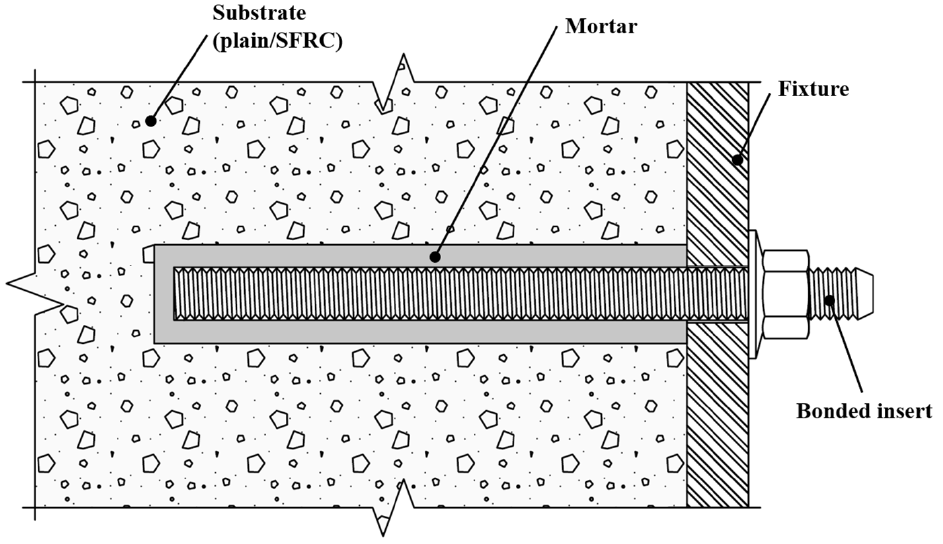
Figure 1. Bonded anchor elements .